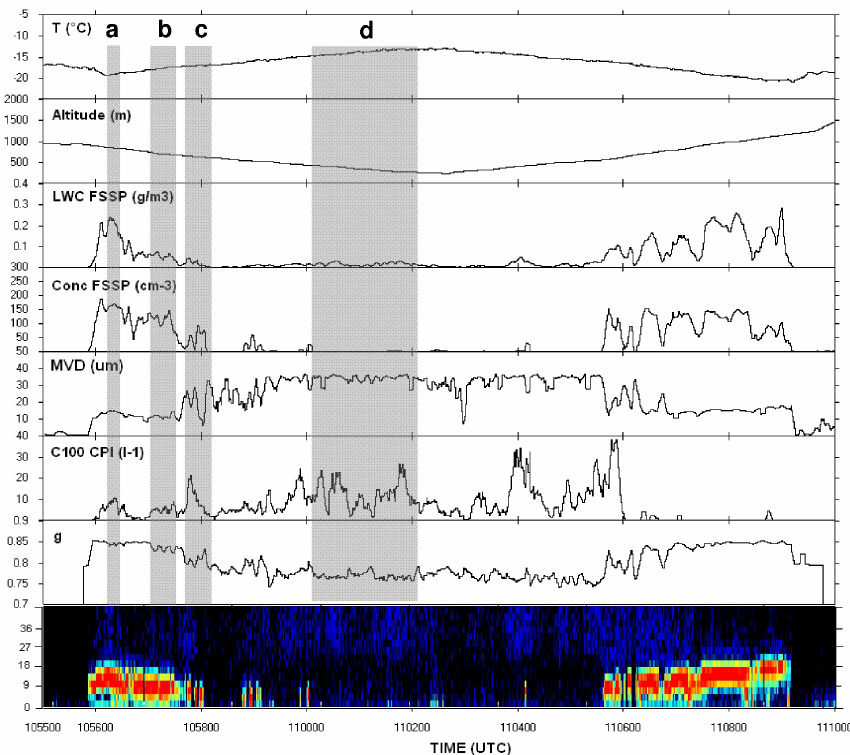
Fig. 1. Time-series of cloud parameters measured during a descent-climbing sequence in the mixed-phase stratiform cloud layer (ASTAR, 8 April 2007 case study). The parameters (plotted at 1Hz) are the following: the air temperature, altitude, liquid water content (LWC), droplet concentration and mean volume diameter (MVD), the concentration of ice particles larger than 100µm ( C 100), the asymmetry parameter ( g) and the FSSP size distribution represented with colour-scaled to the particle